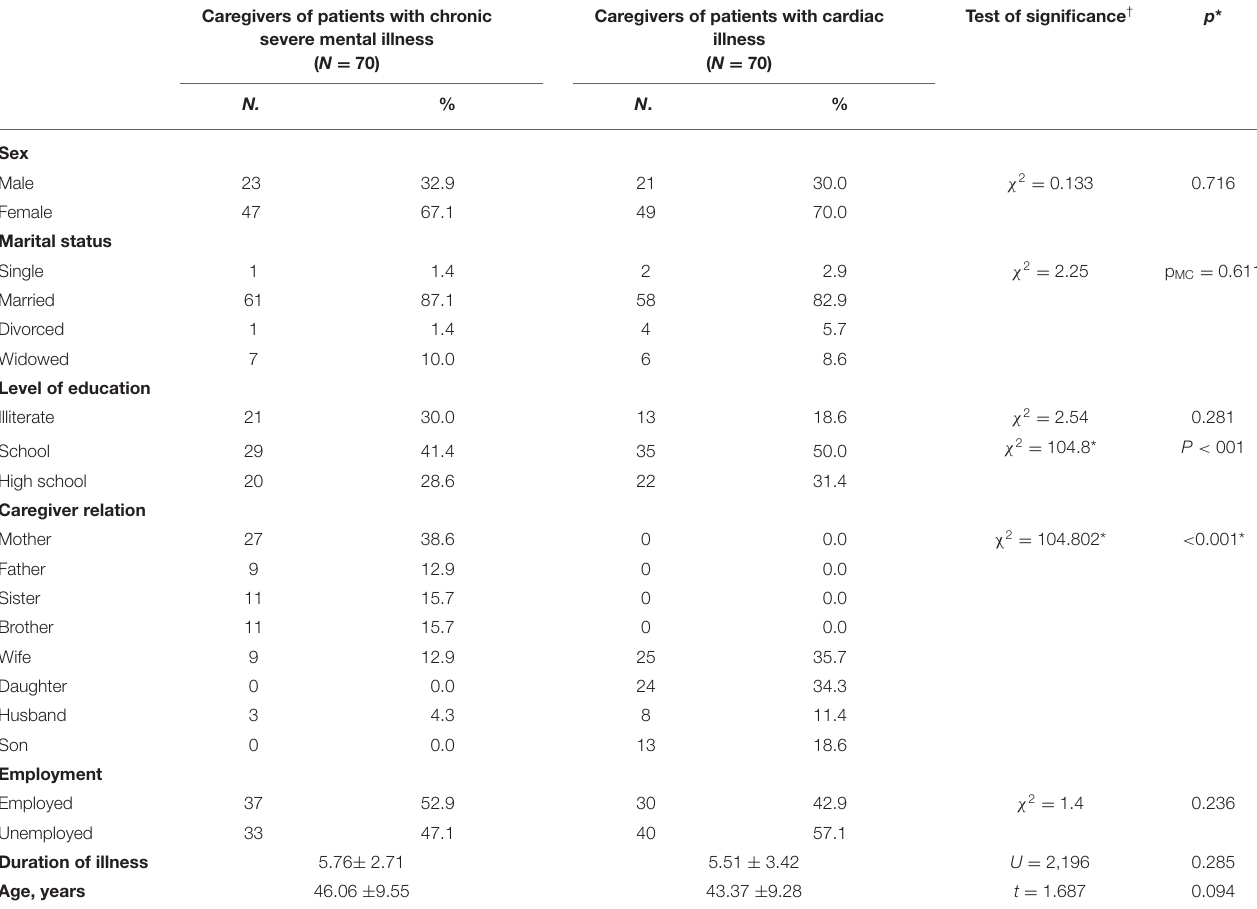
TABLE 1 | Demographic data for caregivers of patients with severe mental illness and patients with cardiac illness (ischemic cardiac disease complicated with chronic heart failure). Caregivers of patients with cardiac Caregivers of patients with chronic severe mental illness